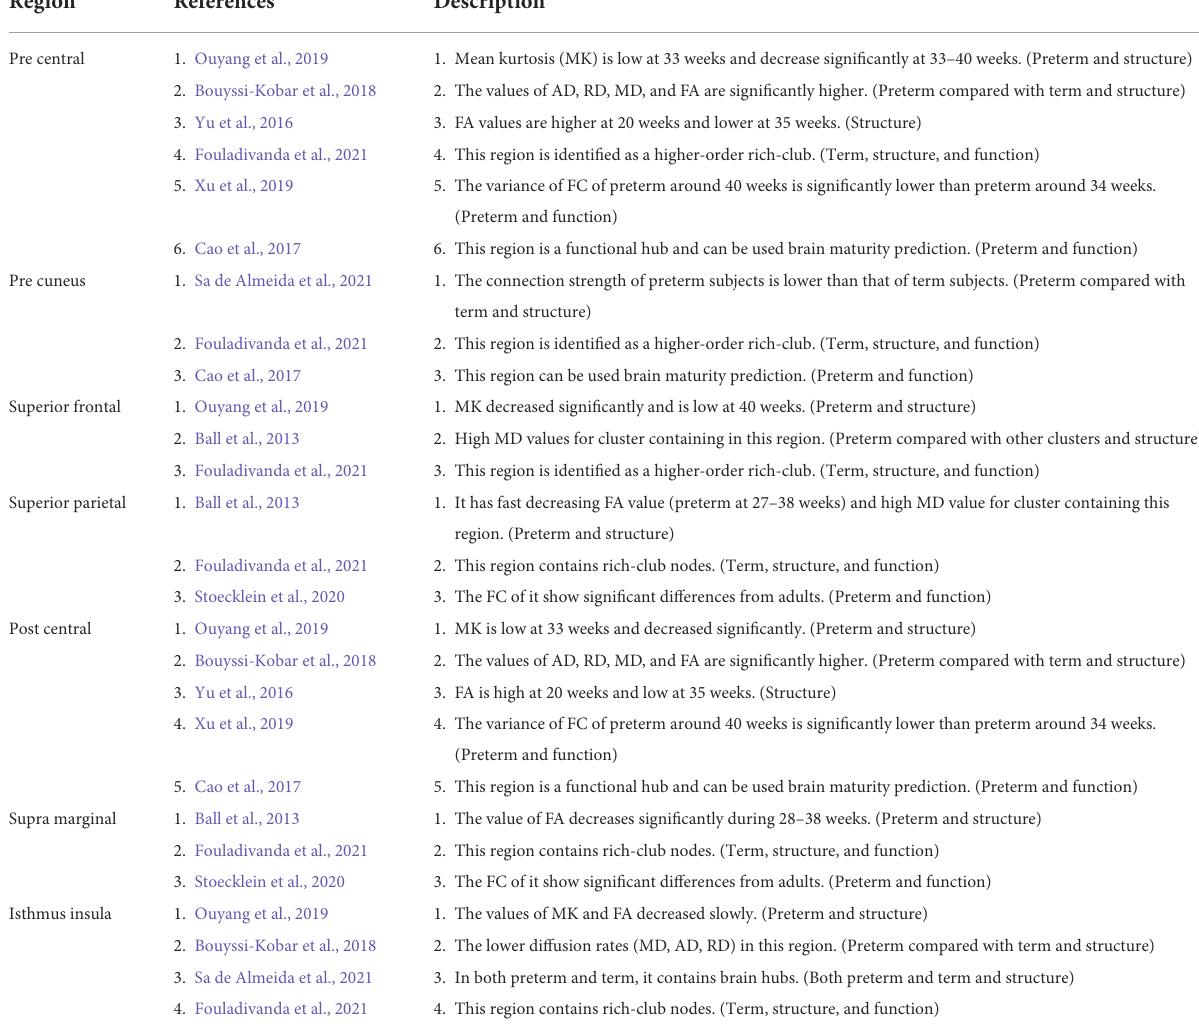
TABLE 3 The literature review of the proposed brain biomarker regions.